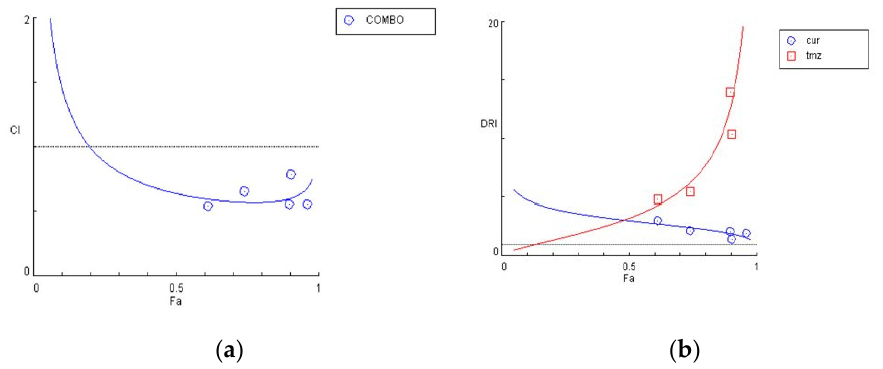
Figure 10. Graphical presentations obtained from the CompuSyn Report for the curcumin and temozolomide combination in U87 cells. ( a ) Combination index plot; ( b ) dose–reduction plot.